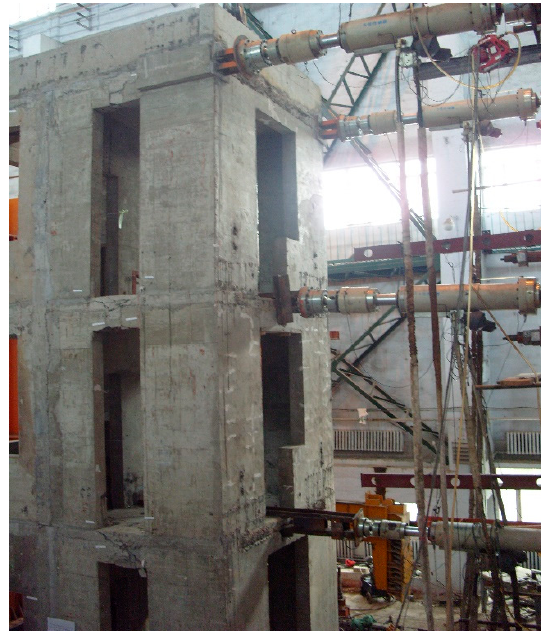
Figure 4. Arrangement of horizontal loading devices.